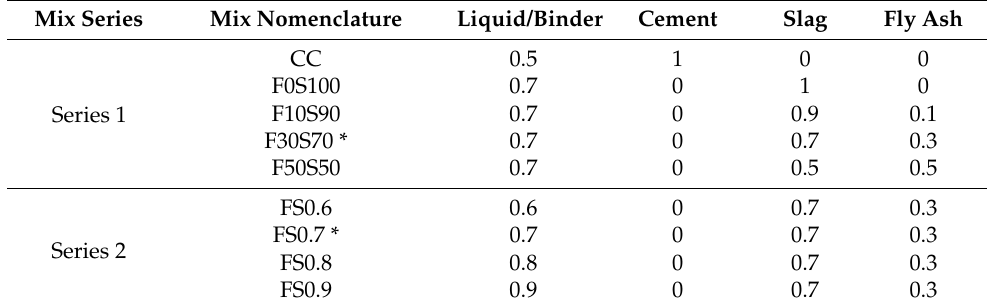
Table 2. Mix proportions of grout.